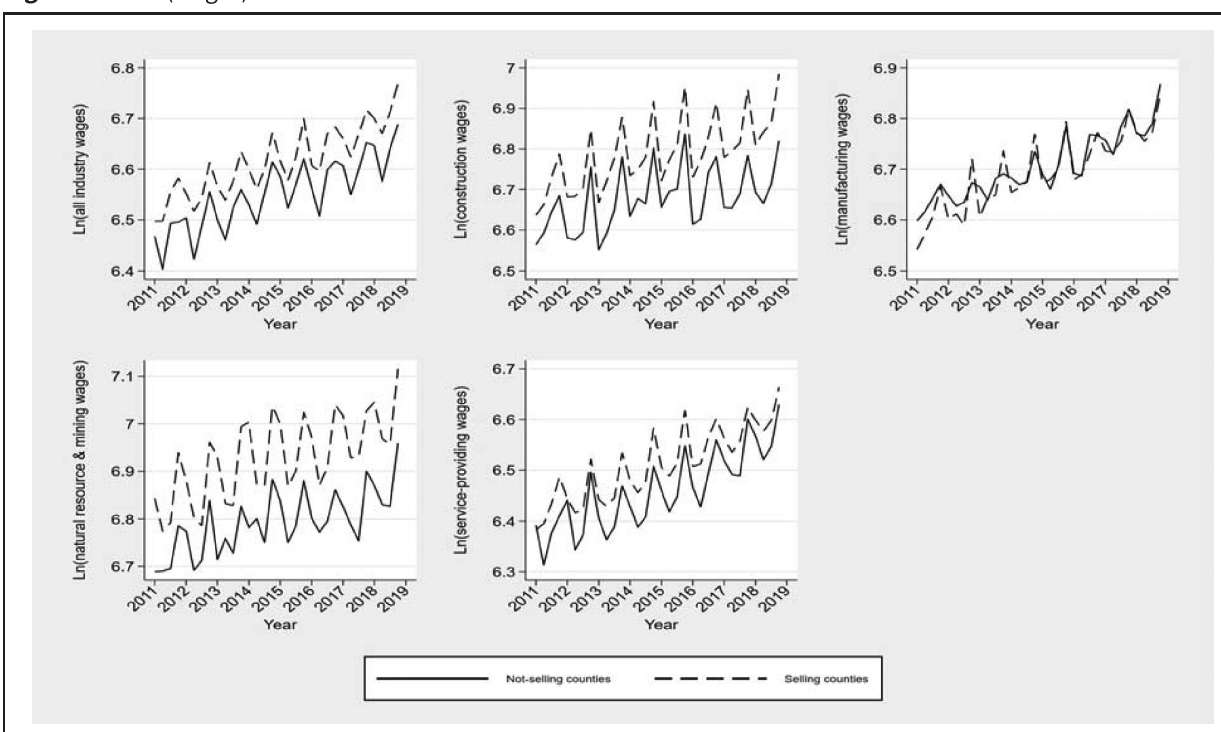
Figure A5 Ln(wages) over